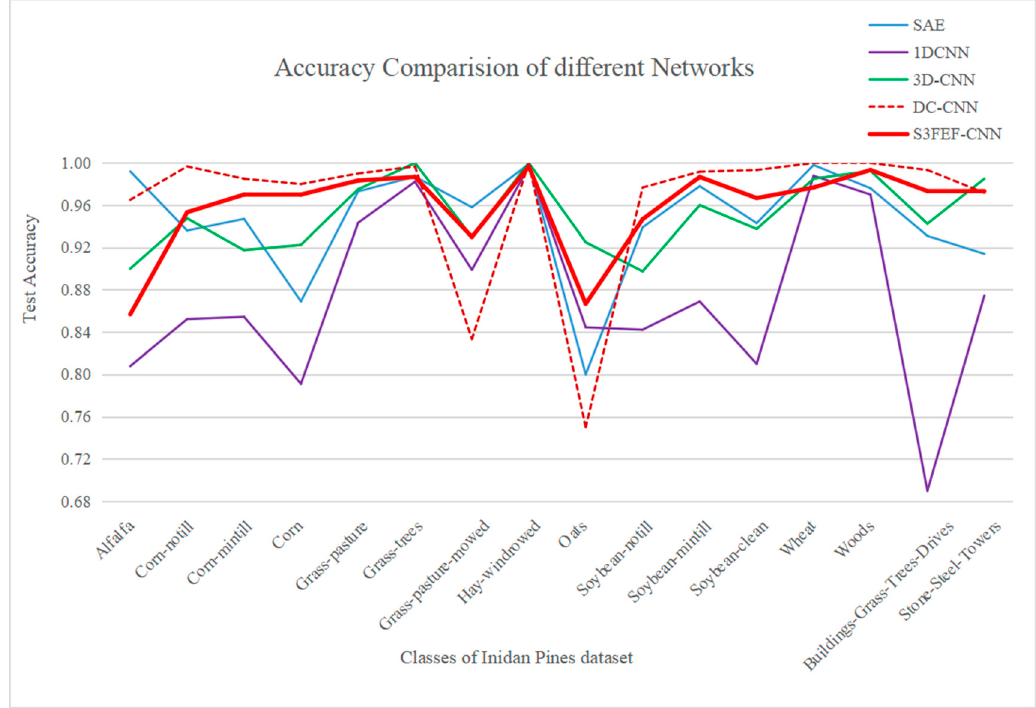
Figure 6. Overall accuracy on Indian Pines (IP) of different networks. It is clear that overall accuracy (OA) curve of S2FEF-CNN is much flatter than the others.